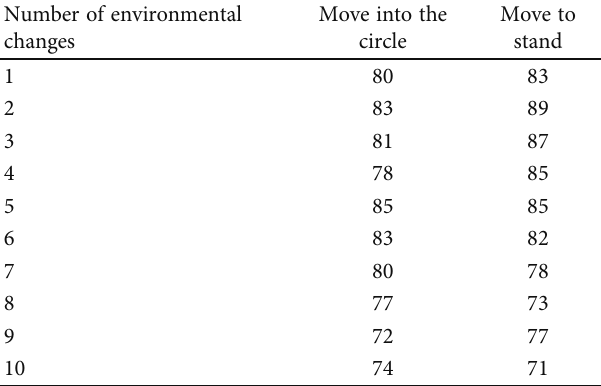
Table 3: Comparison of evolution algebra of target tracking algorithm/generation.